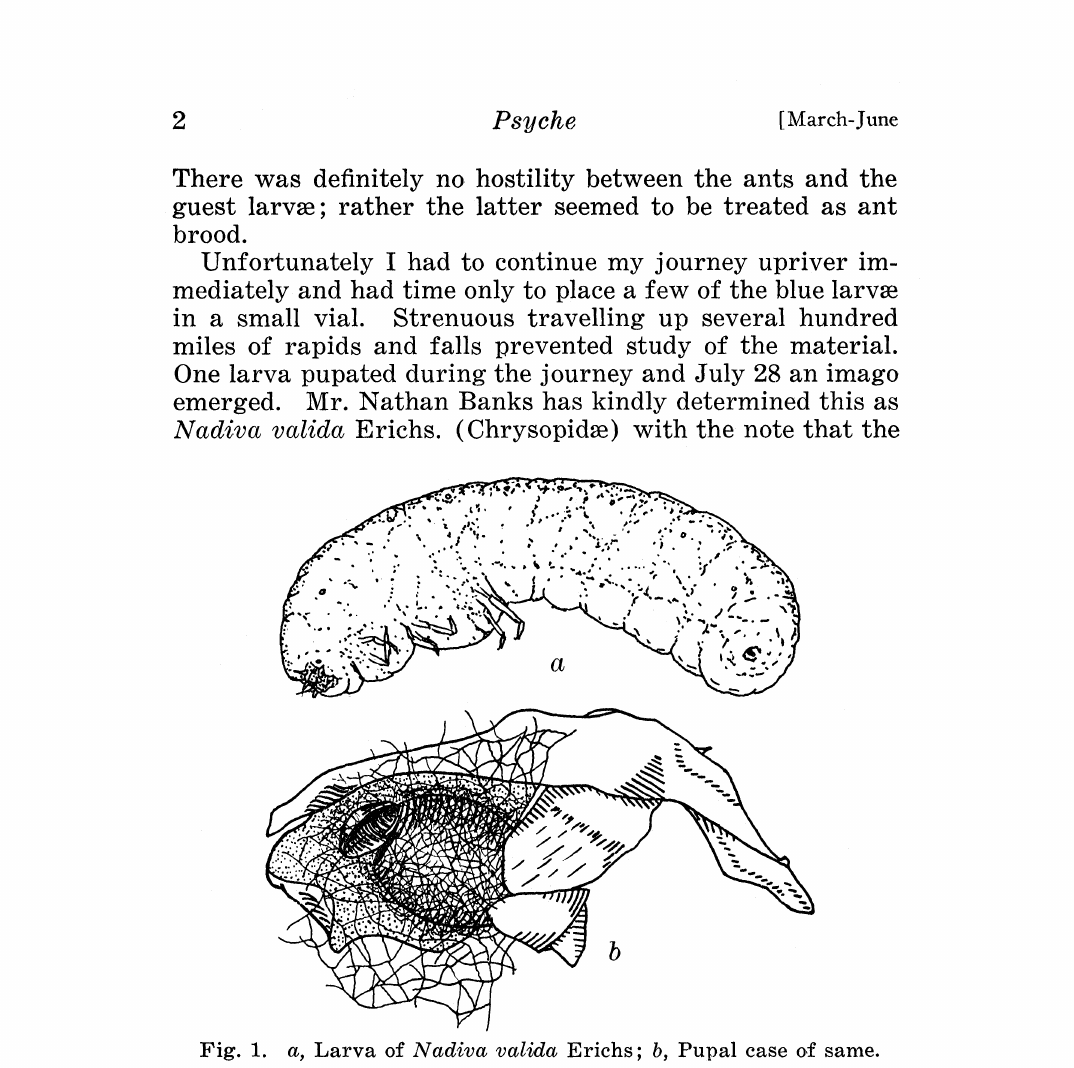
Fig. 1. a, Larva of Nadiva valida Erichs; b, Pupal case o.f same. species "was described from the United States but known also from